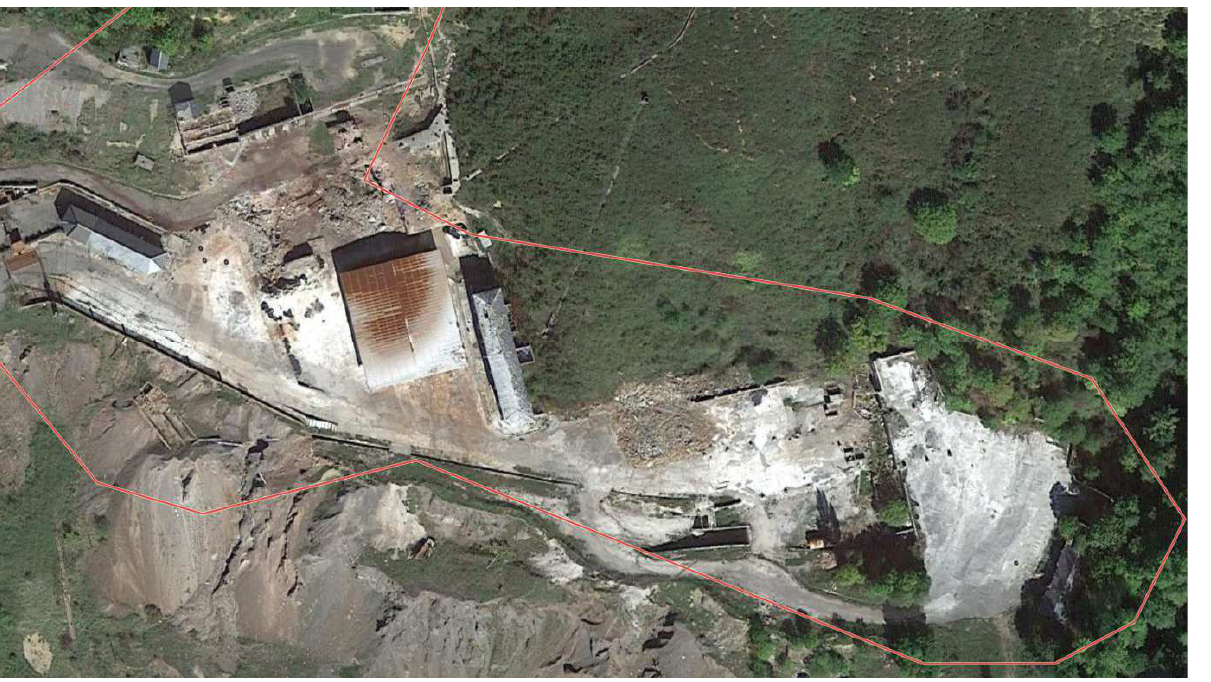
Figure 1. Image of the decommissioned mine.